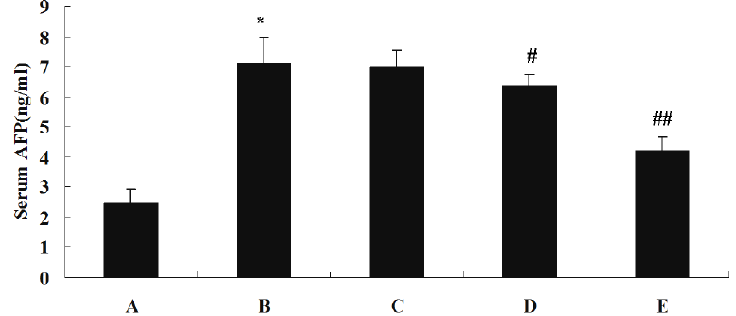
Figure 2. Effect of SJAMP on the levels of serum AFP in rats with DEN-induced HCC. (A) normal control group; (B ) tumor control group; (C) low-SJAMP-dose group (17.5 mg/kg); (D) medium-SJAMP-dose group (35 mg/kg); (E) high-SJAMP-dose group (70 mg/kg). Data are expressed as the means ± SD. * p < 0.01 vs. normal control group; # p < 0.05,